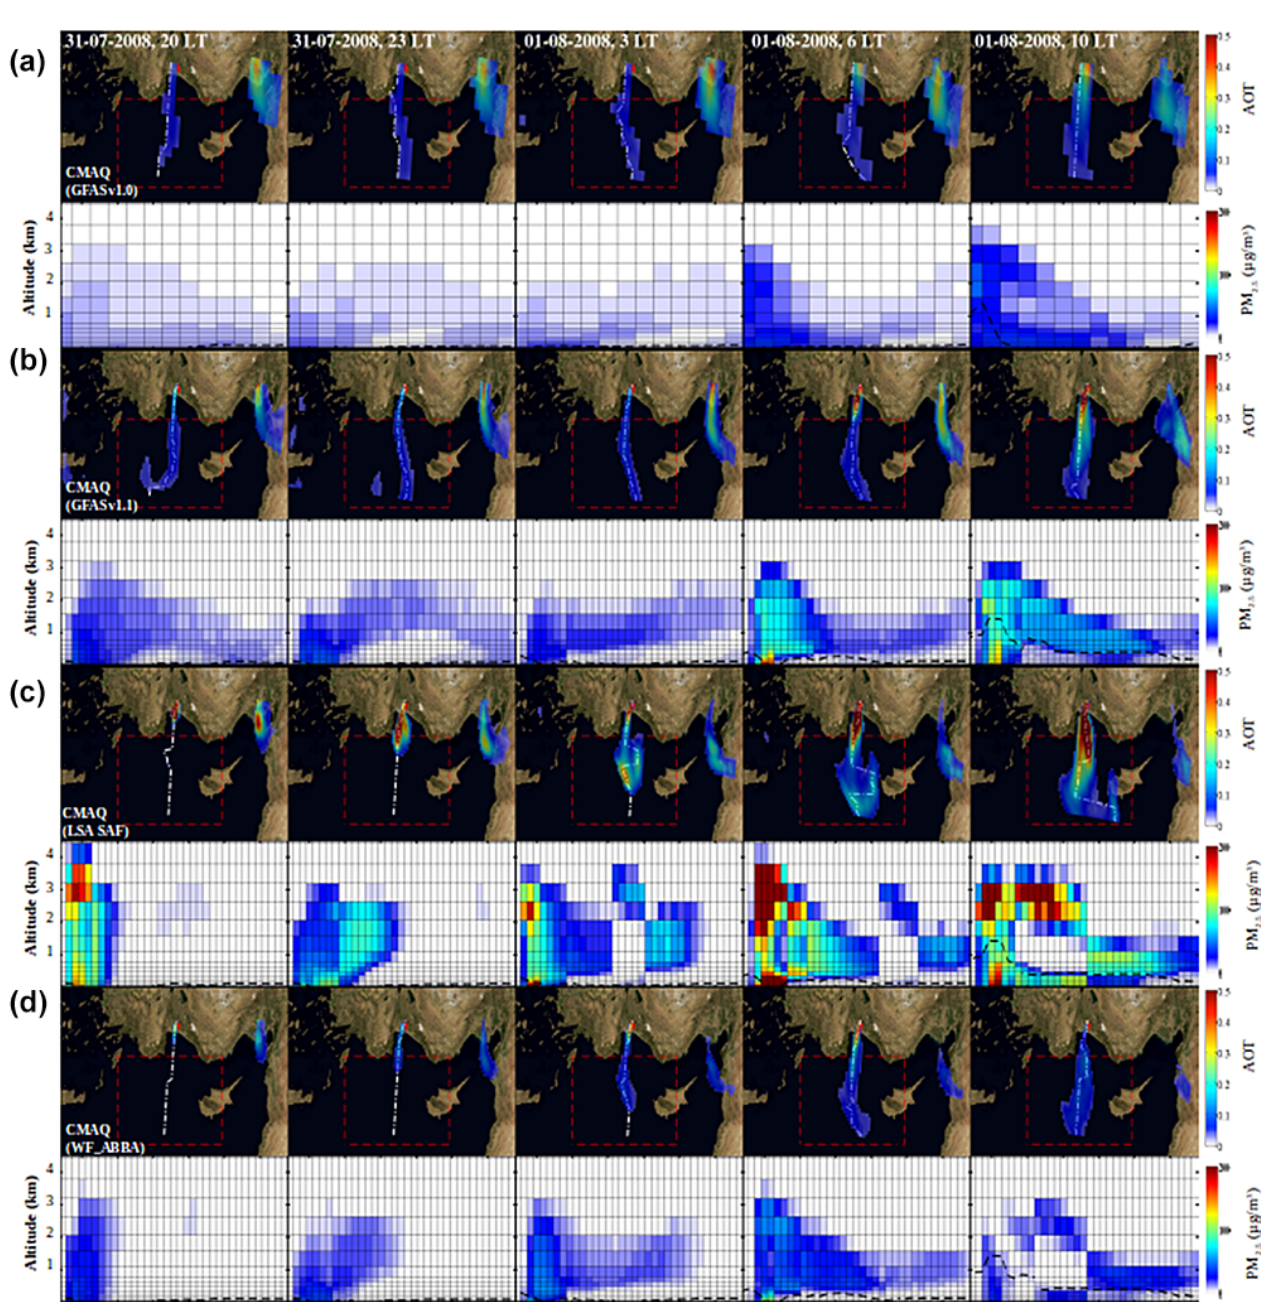
Figure 8. On 31 July 2008 at 20:00LT, 31 July 2008 at 23:00LT, 1 August 2008 at 03:00LT, 1 August 2008 at 06:00LT and 1 August 2008 at 10:00LT. CMAQ-simulated changes in AOT and vertical distribution of fire PM 2 . 5 concentration along the maximum-simulated AOT due to fires using GFAS1.0- (a) , GFAS1.1- (b) , LSA SAF- (c) and WF_ABBA-based (d) fire emission inventories. The changes in the AOT are calculated by subtracting concentrations from simulations without fires. The white-dashed line, in the AOT map, connects the cells of the model grid having the maximum-simulated AOD along the Antalya fire plume. Black-dashed line, in the vertical cross sections, defines the